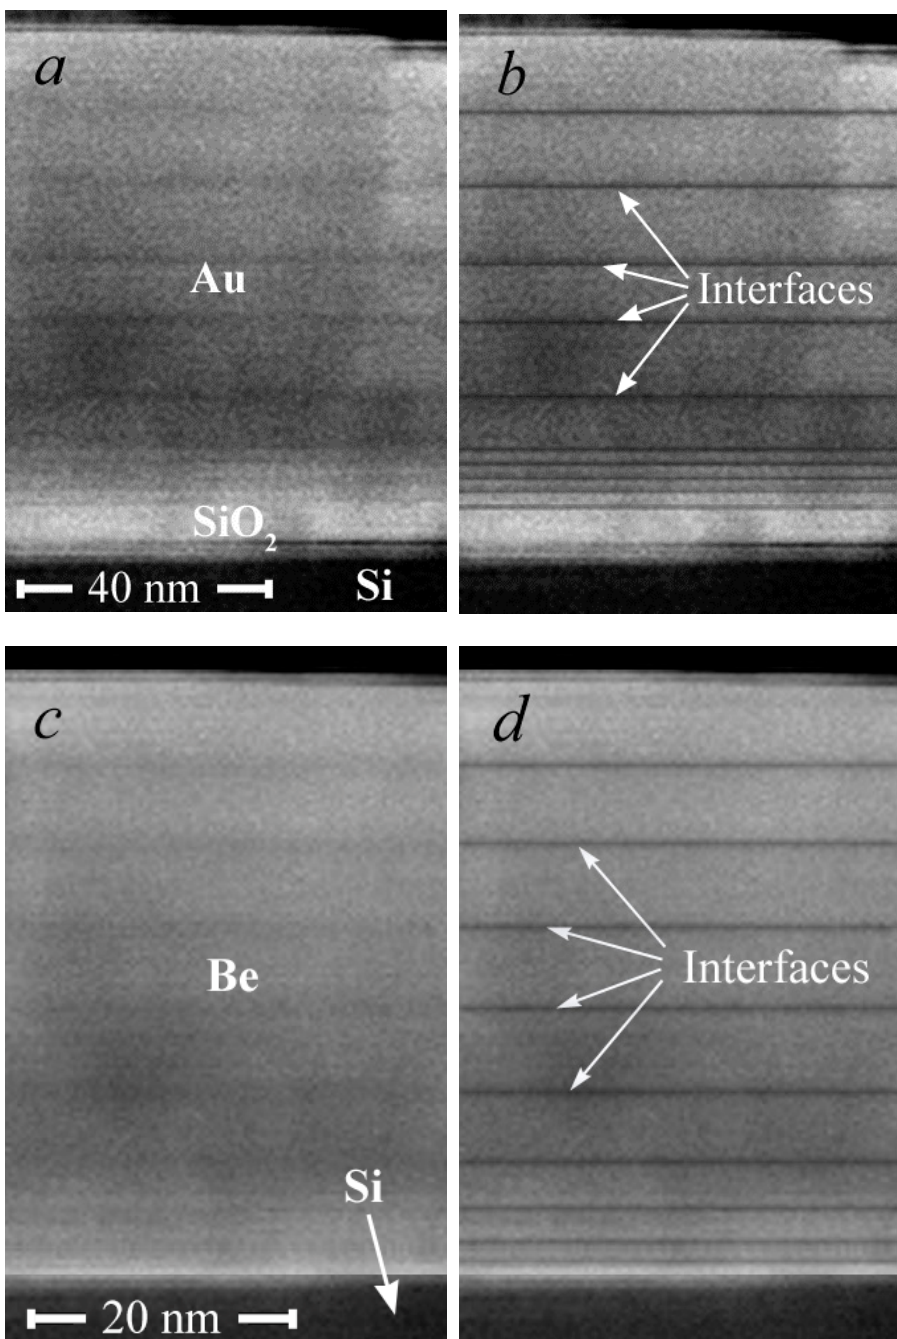
Figure 4. Cross-section SEM image of a 90 nm gold ( a , b ) and 45 nm beryllium ( c , d ) film on silicon substrate after tenfold deposition. The radiation-modified areas are artificially highlighted during image processing in the right figures ( b , d